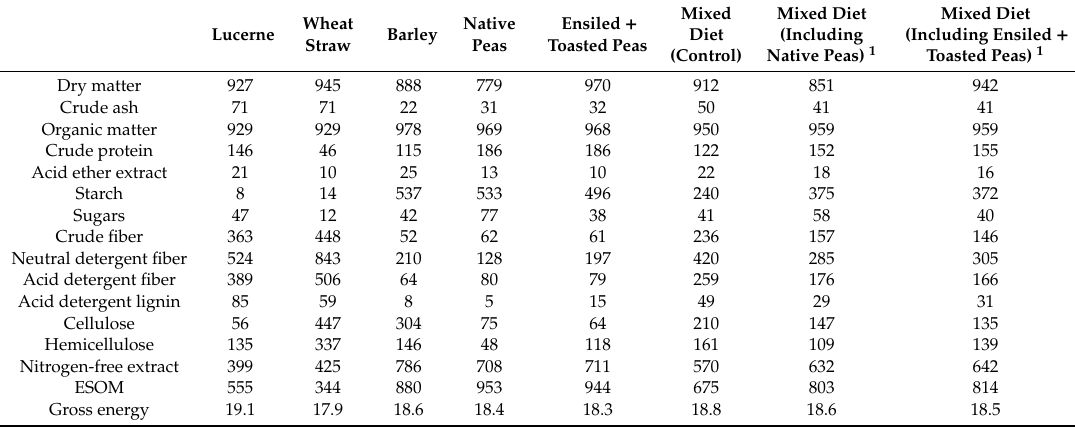
Table 3. Chemical composition of the feeds and the diets used in the experiment. Wheat Native Ensiled + Lucerne Barley Peas Toasted Straw